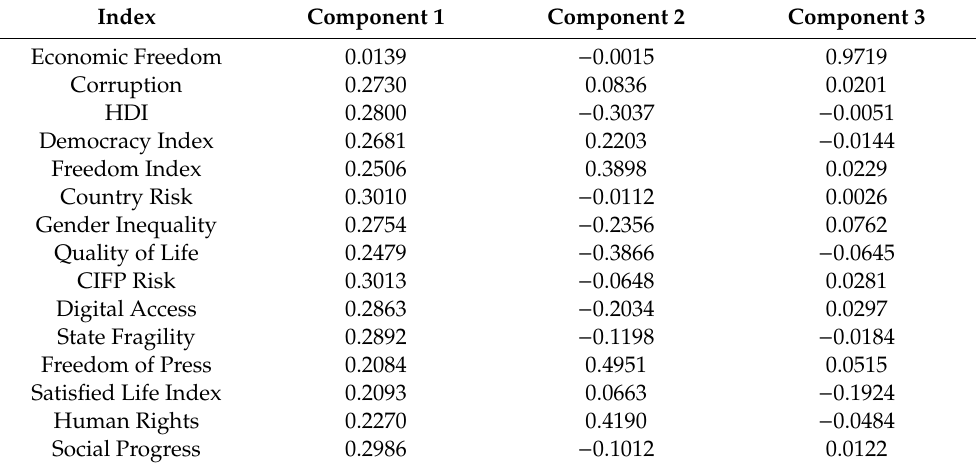
Table 3. Component